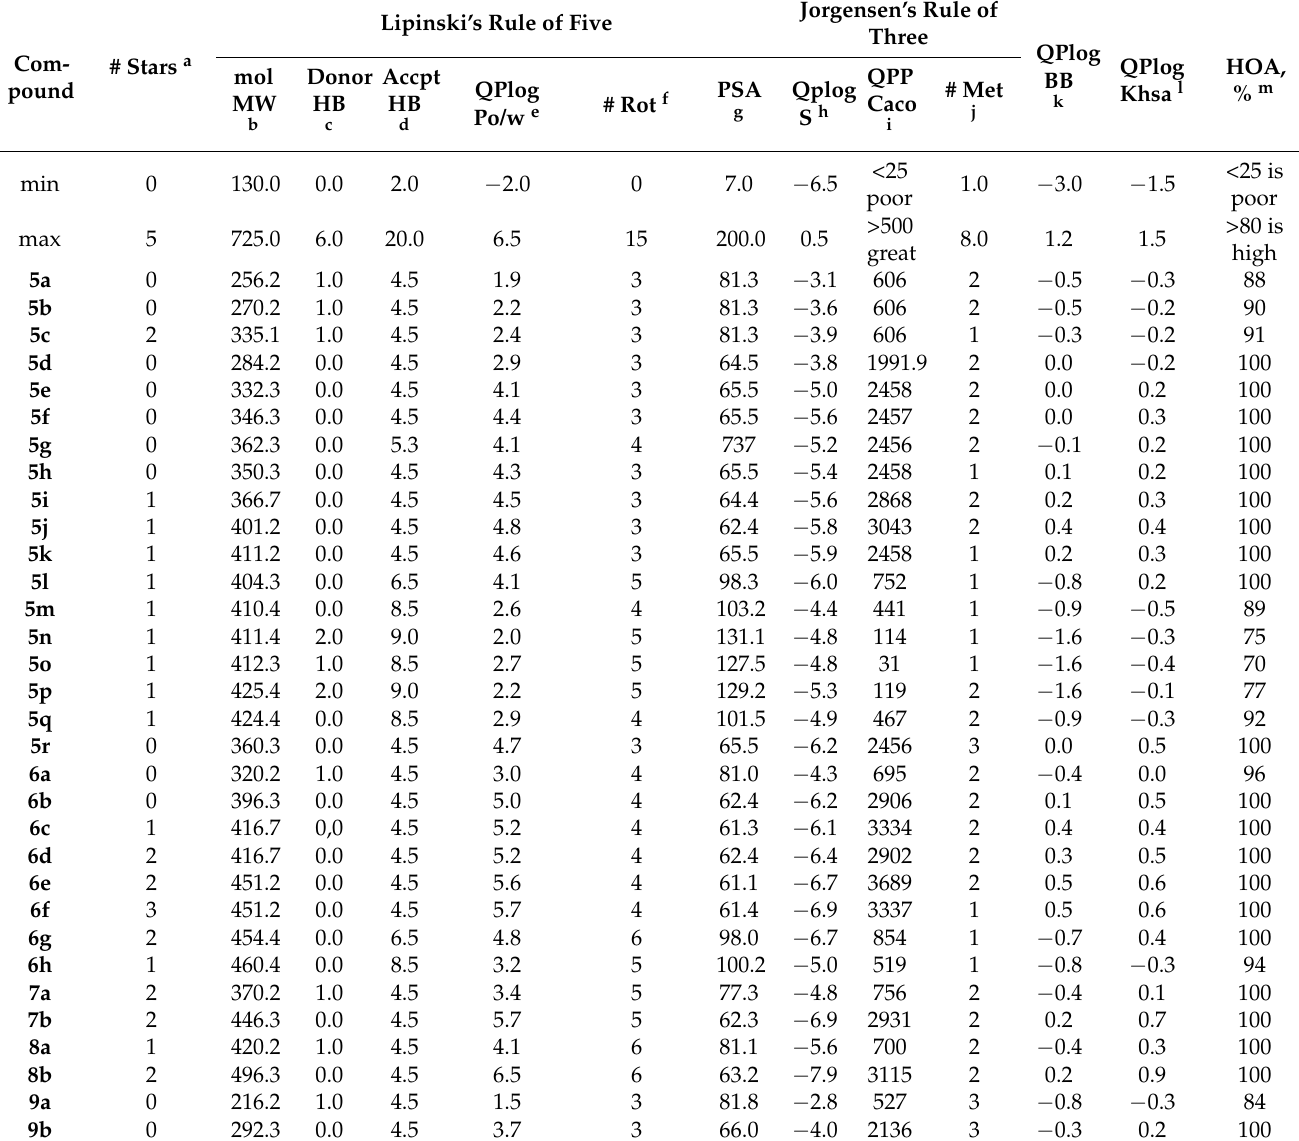
Table 2. In silico ADME predictions of 4-AHPs 5–9